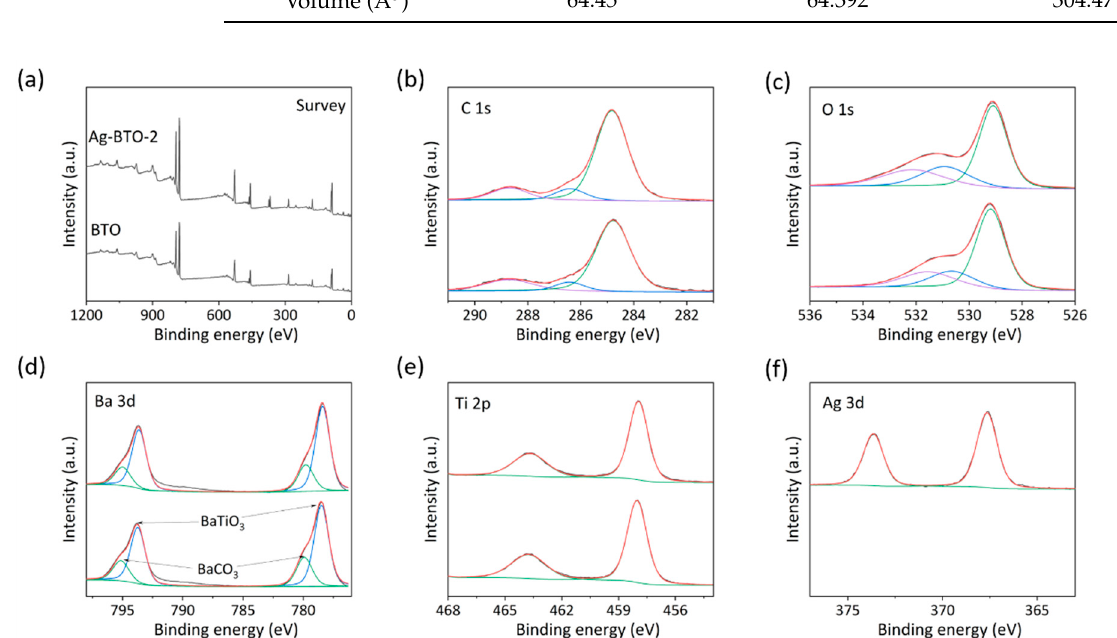
Figure 4. The XPS spectra of BTO and Ag-BTO. ( a ) Survey spectra. ( b ) C1s. ( c ) O 1s. ( d ) Ba 3d. ( e ) Ti 2p. ( f ) Ag